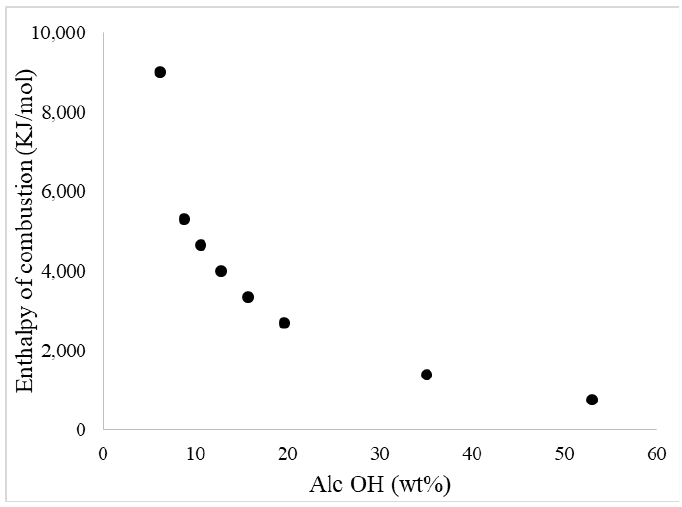
Figure 7. The effect of weight percentage of OH on enthalpy of combustion for alcohols .